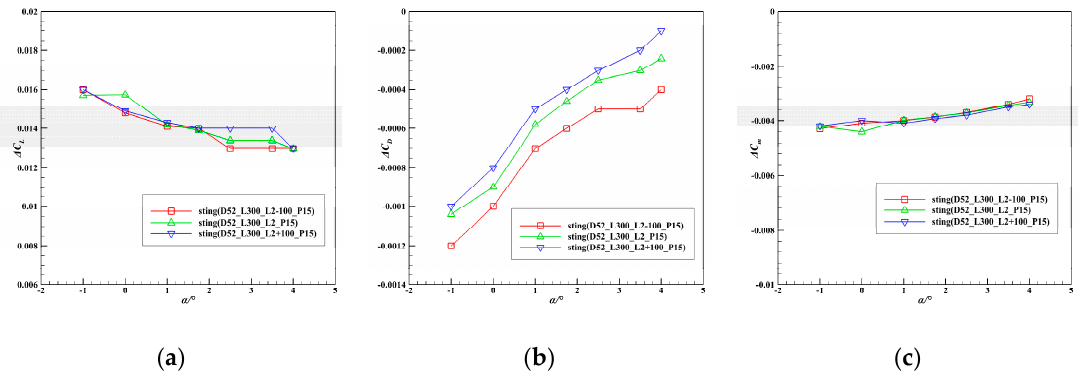
Figure 10. Pressure contour and distribution of the BWB aircraft with different straight-section lengths (L = 200 mm/300 mm/400 mm, Ma = 0.75, α = 0°): ( a ) pressure contour of the BWB aircraft under the L = 200 mm condition; ( b ) pressure distribution of profile F-F (position of F-F is shown in Figure 10a).